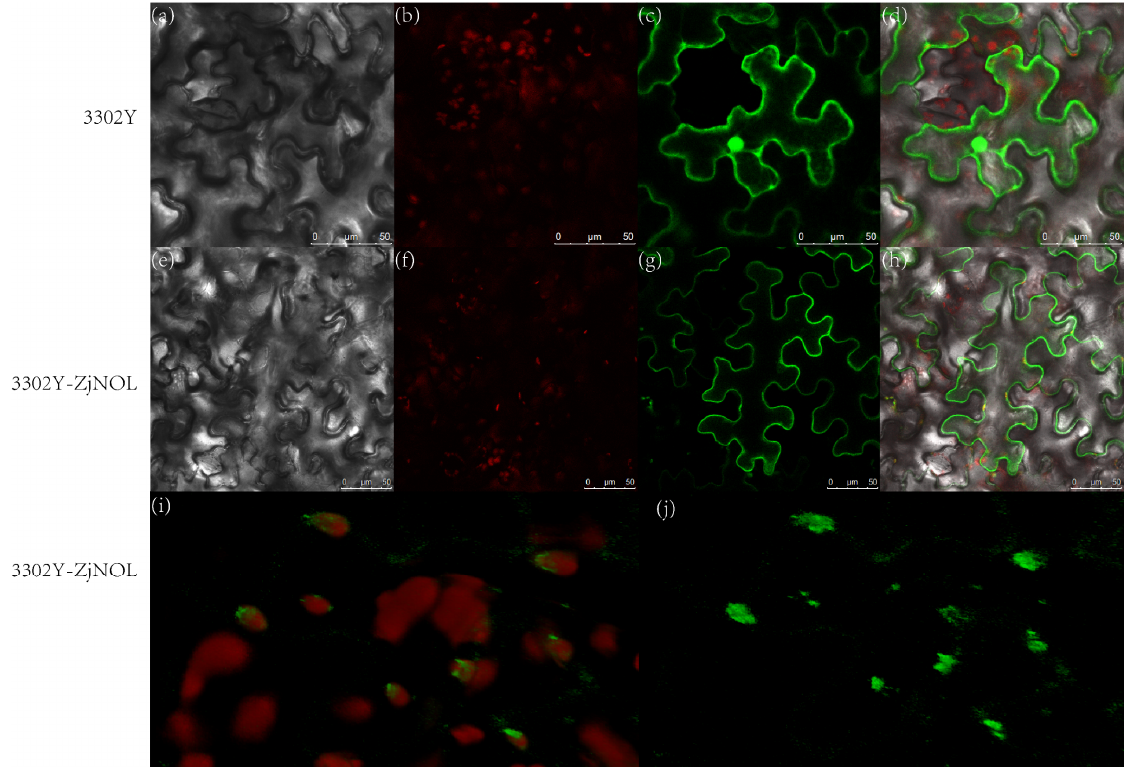
Figure 6. Subcellular localization of ZjNOL in cells. ( a – d ) YFP fluorescent detection. ( e – j ) Fusion protein of ZjNOL and YFP fluorescent detection. a , e : Bright light; b , f : chlorophyll autofluorescence; c , g , j : YFP fluorescence; d , h , i : merged